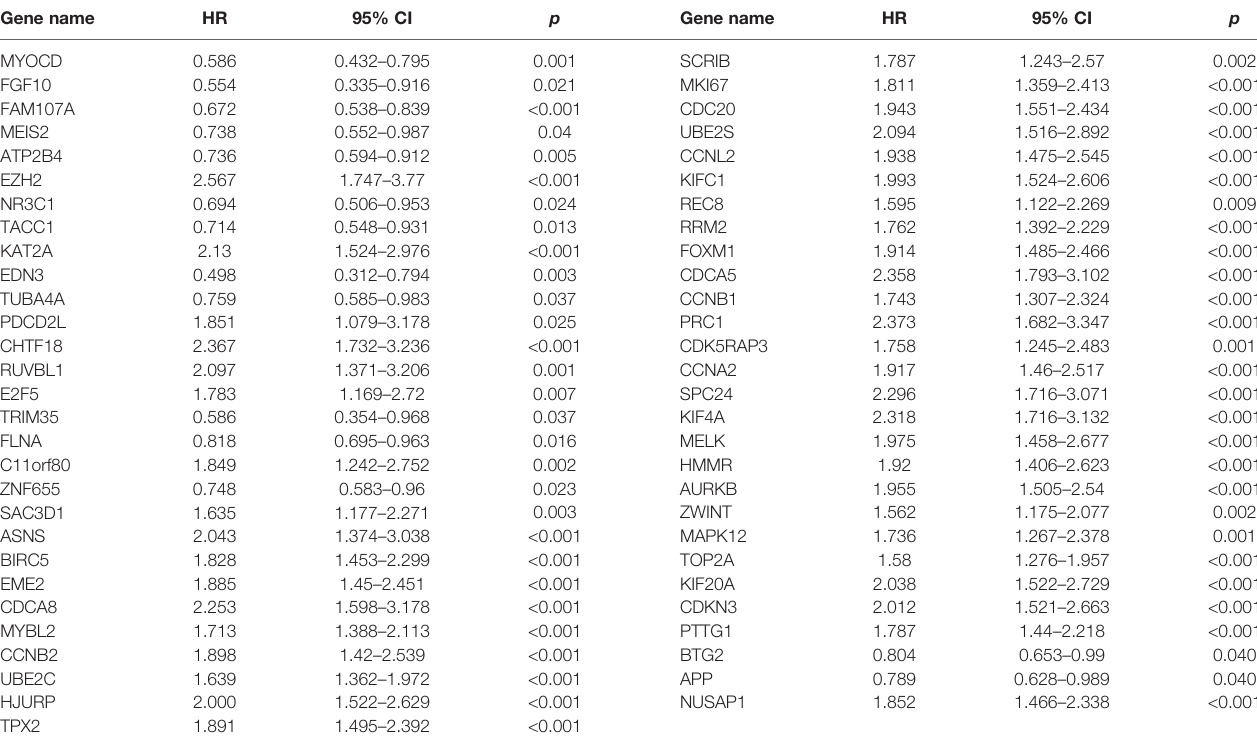
TABLE 1 | Univariate Cox regression analysis of differentially expressed